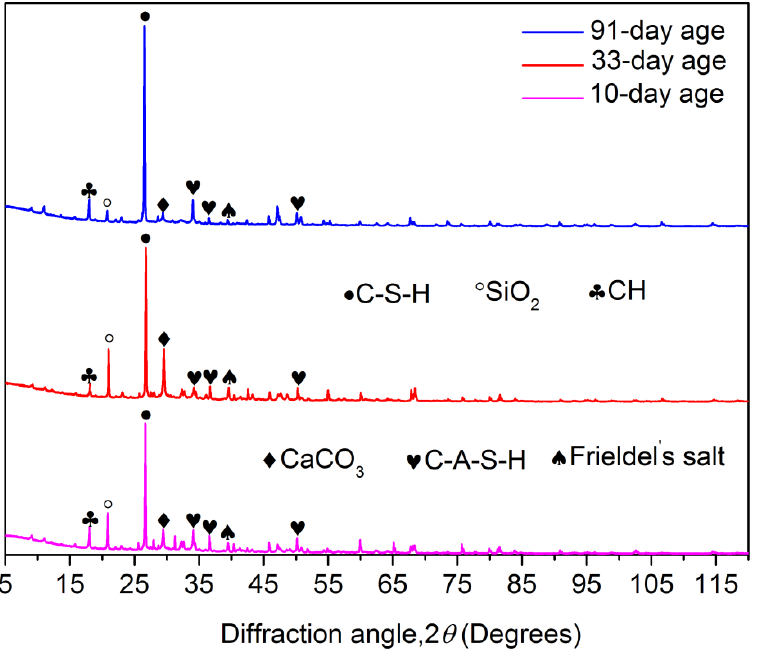
Figure 13. Mortar XRD patterns.